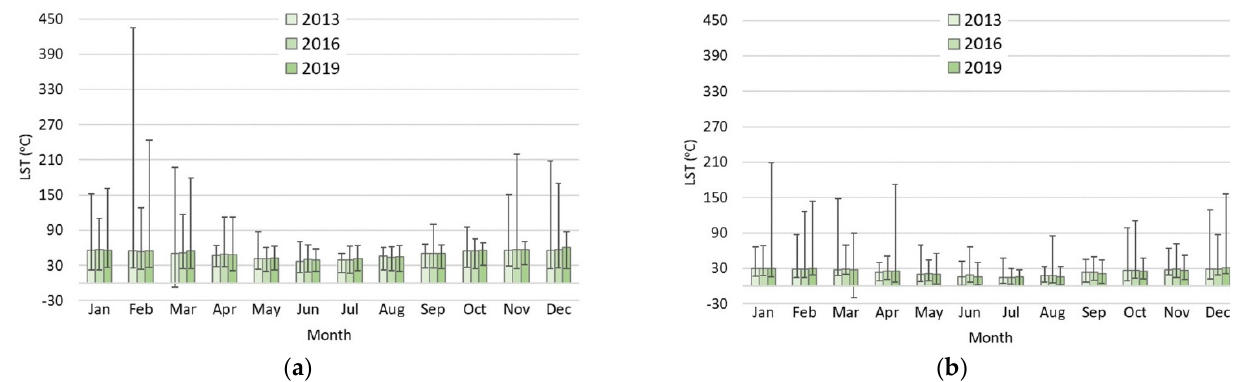
Figure 9. Kimberley VNP21A2 mean and min/max LST: ( a ) day and ( b ) night.